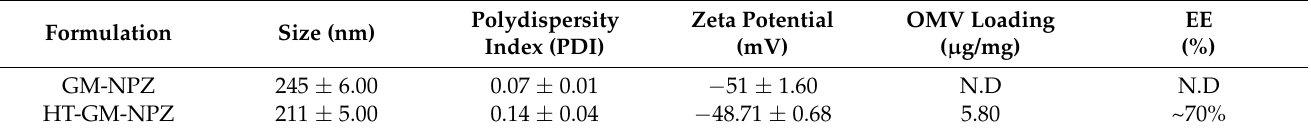
Table 3. Physicochemical characterization of Enterotoxigenic Escherichia coli (ETEC) outer membrane vesicles (OMV)-containing nanoparticles. EE: encapsulation efficiency. Data expressed as mean ± SD (n > 3).